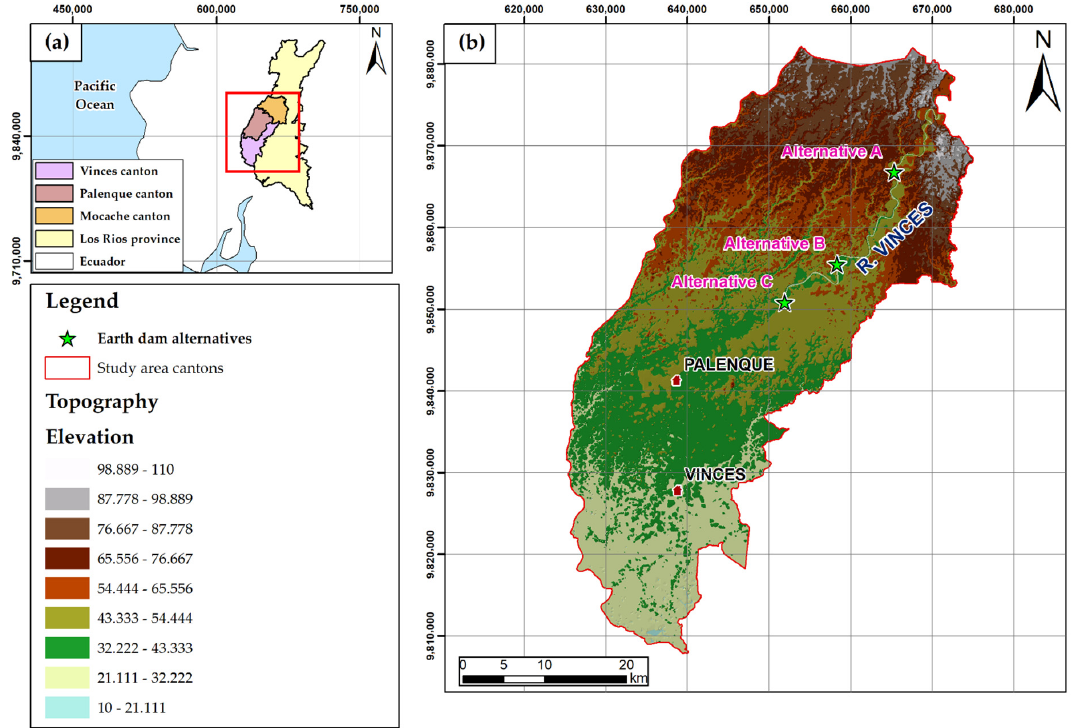
Figure 4. ( a ) Location of the main cantons in the study area; ( b ) The general topography of the study area with the location of the three alternative locations of the earthen dams.